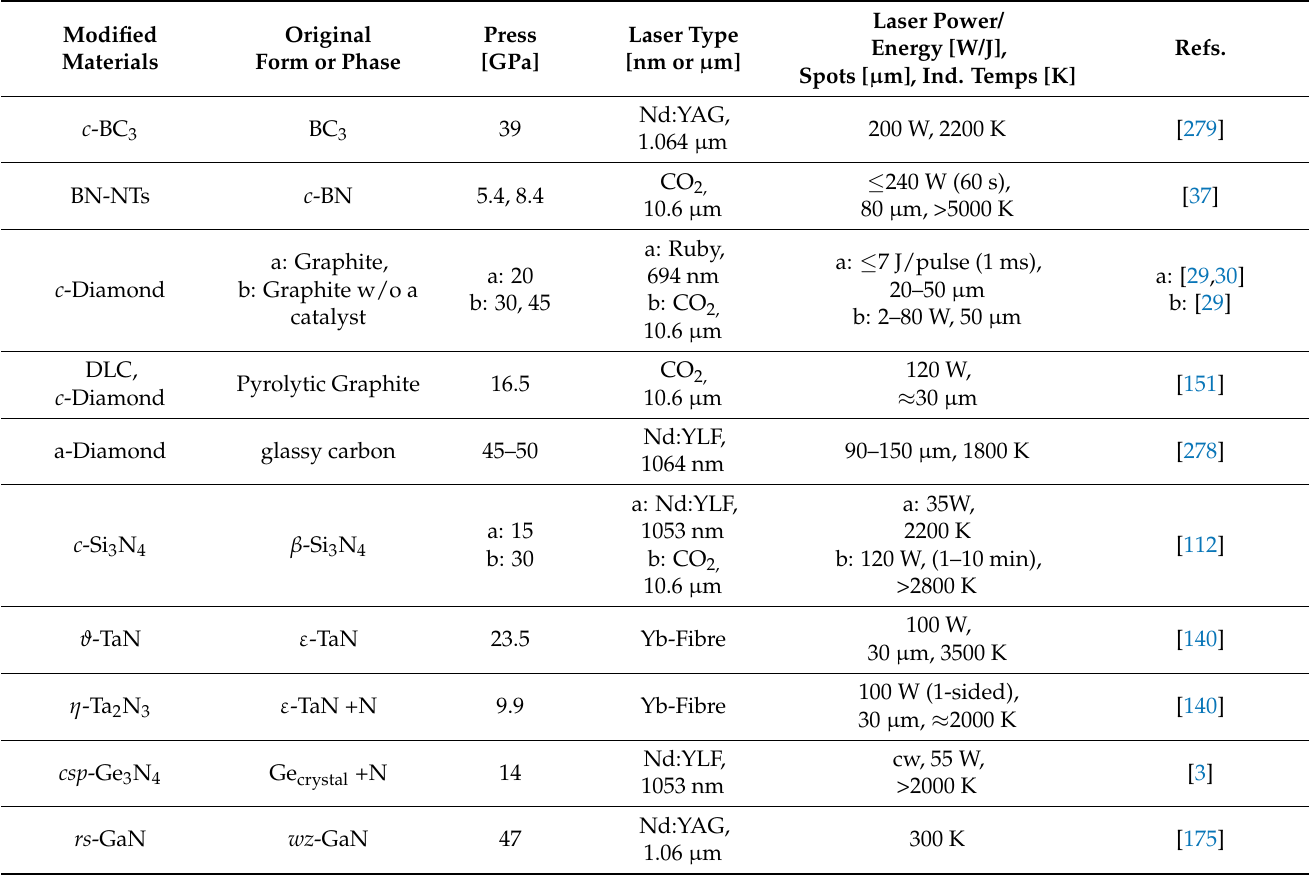
Table 3. Physical processes and experiment parameters of industrial materials produced in selected LH-DAC studies.